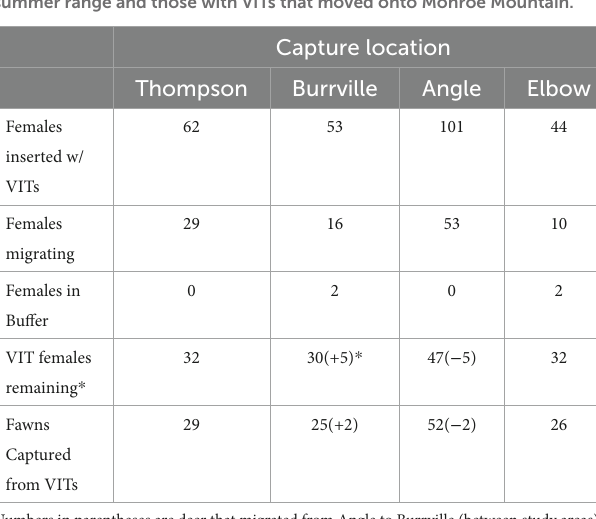
TABLE 1 The distribution of female mule deer captured from four regions of wintering range around Monroe Mountain, Utah during 2012–2015, including the number of captured animals that migrated to a different summer range and those with VITs that moved onto Monroe